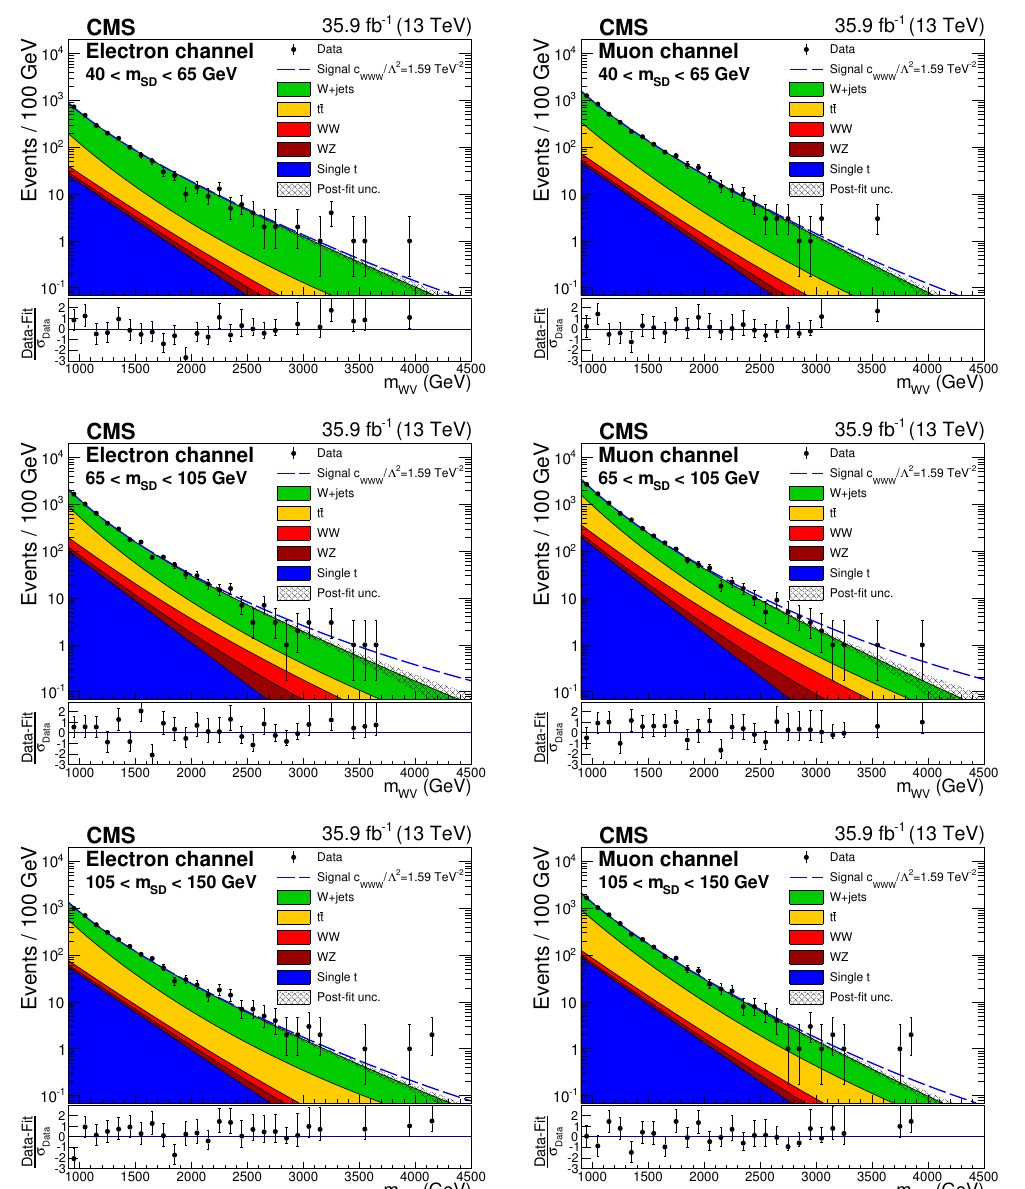
Figure 4 . Final result of the two-dimensional (cid:12)t in the electron (left) and muon (right) channels, showing the m distributions. The lower sideband, signal, and upper sideband regions are shown WV on the top, middle, and bottom, respectively. An example of the excluded signal ( c 1 : 59 TeV (cid:0) 2 ) is represented by the dashed